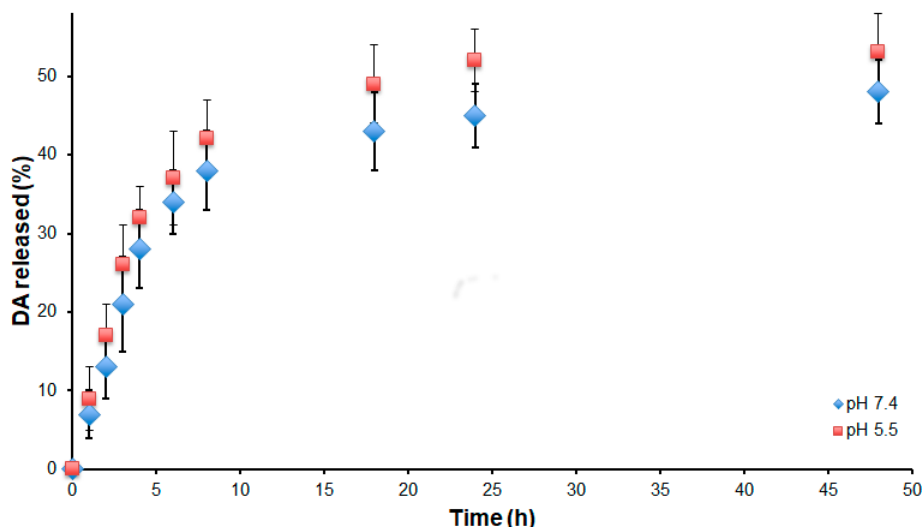
Figure 2. In vitro DA release profiles from CS(DA) NPs in PBS solutions at a pH of 7.4 (blue dots) and a pH of 5.5 (orange dots) at 37 °C. Error bars represent the standard deviation values calculated from three independent experiments.